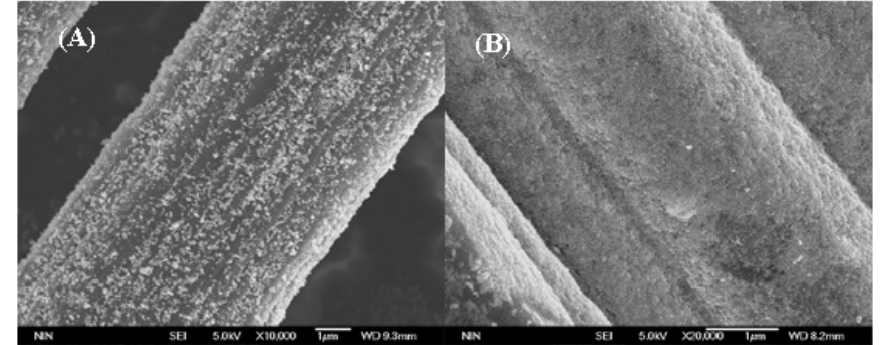
Figure 3. Scan electronic microscope images of Fe@CC obtained at ( A ) 160 °C, ( B ) 200 °C.